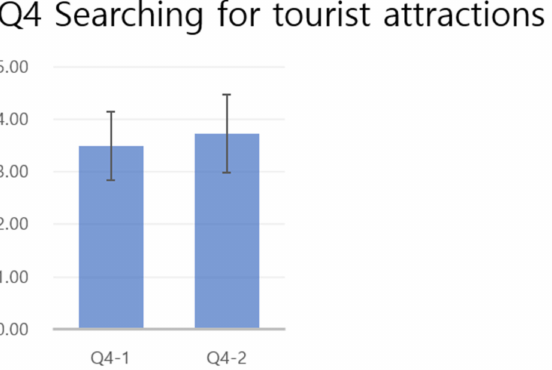
Figure 14. Results showing user service satisfaction with searching for tourist